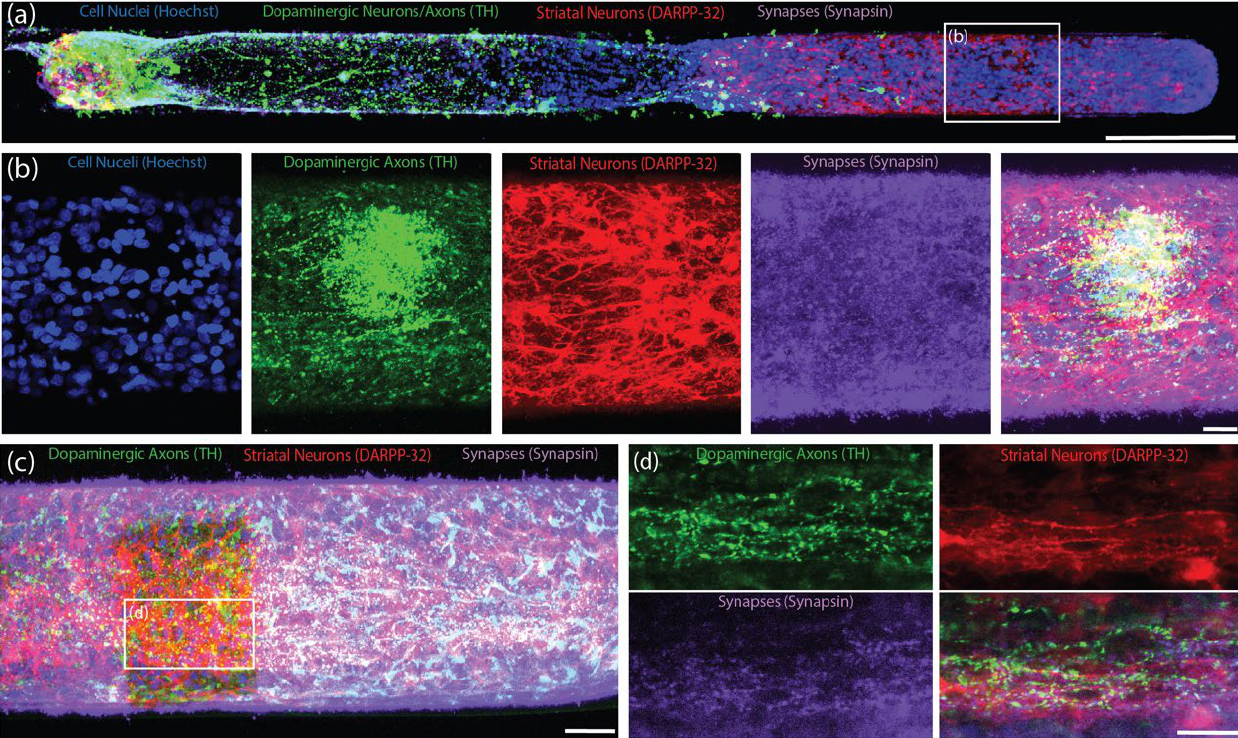
Figure 4. Bidirectional TE-NSPs with Surrogate Striatal Neuron End Targets. Representative confocal reconstructions of TE-NSPs at 14 DIV labeled via immunocytochemistry to denote dopaminergic neurons/axons (TH, green), striatal medium spiny neurons (DARPP-32, red), and synapses (synapsin, purple), with nuclear counterstain (Hoechst, blue). ( a ) An enriched TE-NSP (dopaminergic neurons on the left side) plated with an aggregated striatal end target (located on the right side). ( b ) Higher- magnification reconstructions from a demonstrative region in ( a ) depicting dense dopaminergic neurite outgrowth and containing a high degree of synapsin labeling (purple) within the striatal aggregate. ( c ) A striatal aggregate end target within a bidirectional, enriched TE-NSP. ( d ) Higher- magnification reconstructions from a demonstrative region in ( c ) depict synapsin+ puncta (purple) decorating putative dendrites projecting from striatal neurons (red) shown with dopaminergic axonal varicosities (green). Scale bar ( a ) = 250 µ m. Scale bar ( b ) = 20 µ m. Scale bar ( c ) = 50 µ m. Scale bar ( d ) = 25 µ